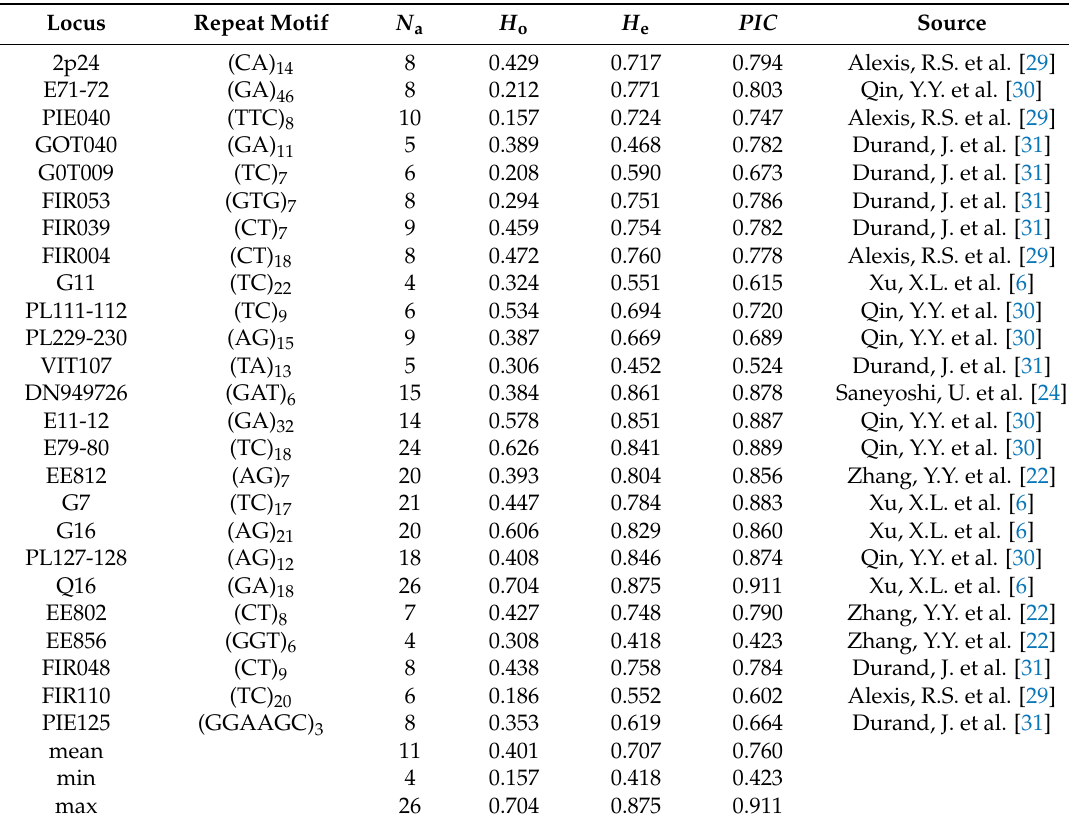
Table 2. Source, repeat motif, and polymorphism information for the 25 microsatellite loci analyzed in the 879 Q. variabilis